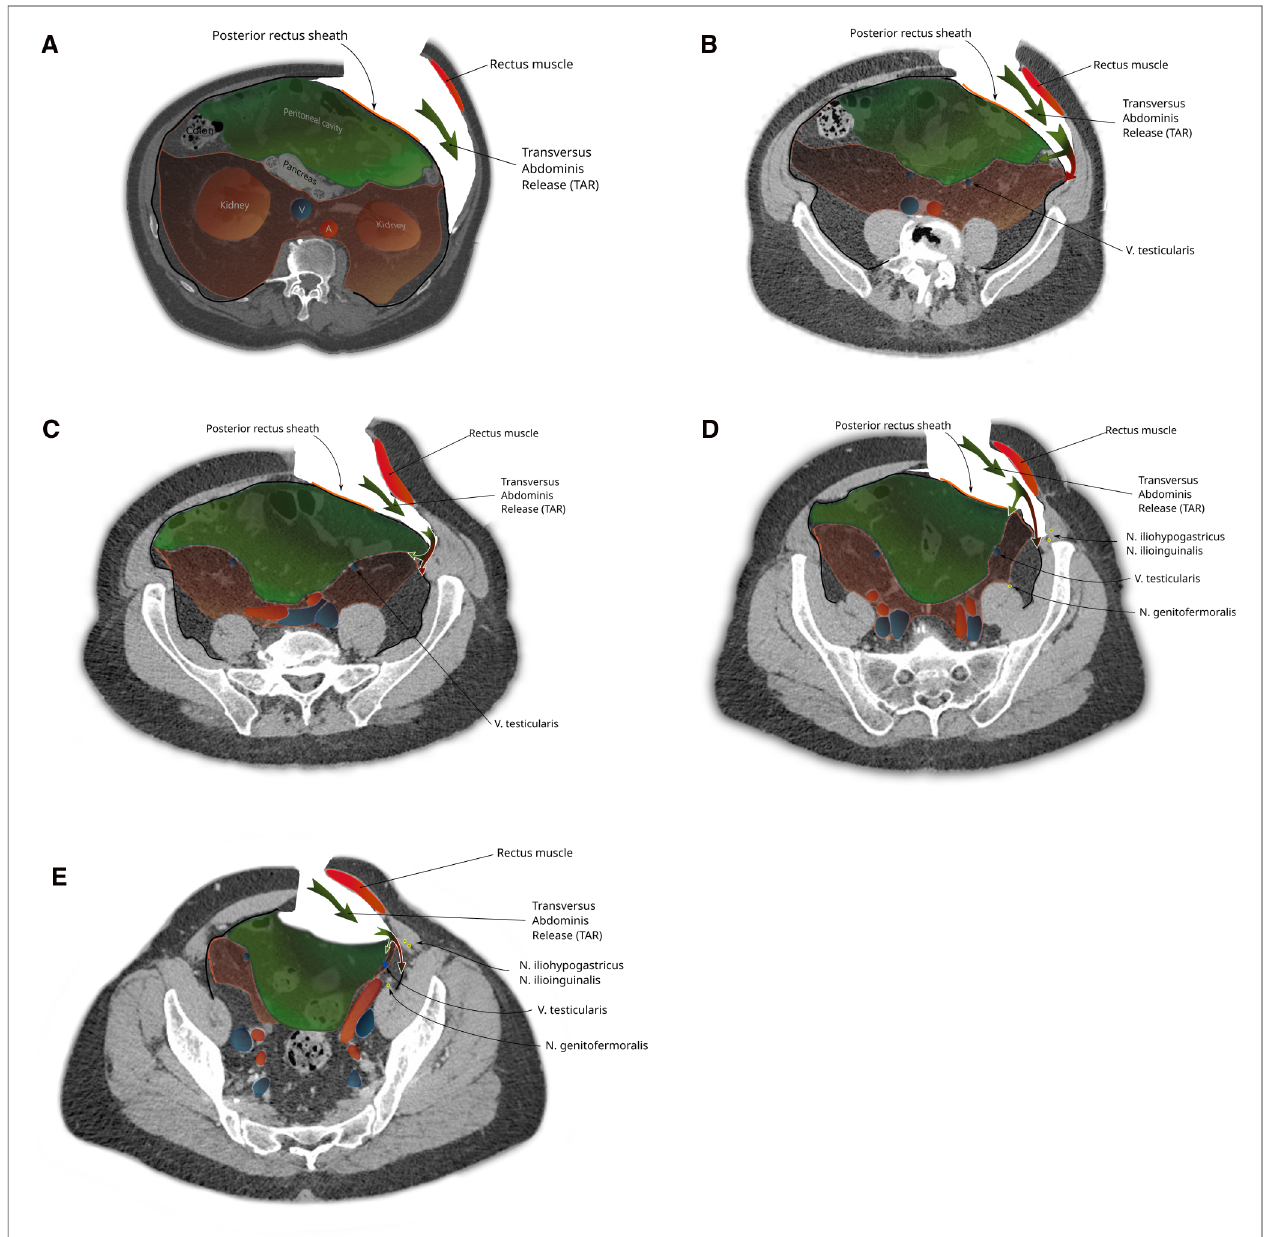
FIGURE 6 | The steps of a transversus abdominis release-maneuver (TAR): (A) Lateral incision of the posterior rectus sheath and dorsolateral dissection along the transverse abdominis muscle (green arrow). Caudal extension of the dissection follows the urogenital fascia into the pelvis (B-E) reaching the space of Bogros in the super fi cial parietal layer that is so carefully avoided during a TEP procedure (red part of bifurcated arrow). A switch of dissection into the deep visceral layer, analogue to the dissection in TEP is necessary if a prosthetic mesh should also cover a groin hernia (green part of bifurcated